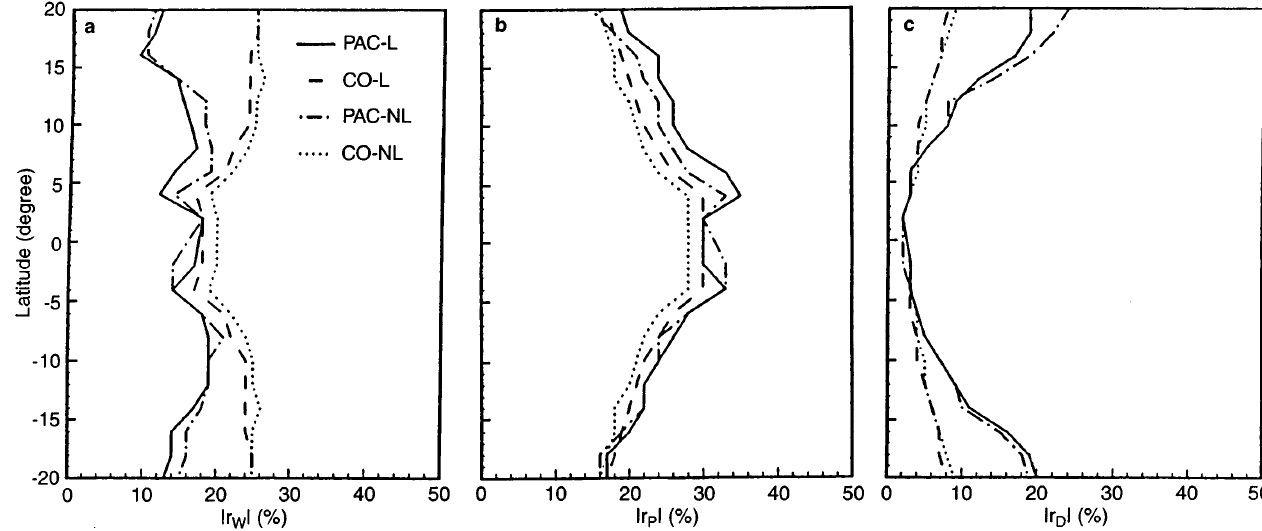
Fig. 2a–c. Energy flux coe(cid:129)cients (%) at di(cid:128)erent latitudes (degree). a r , b r and c r . Solid line : linear experiment with Pacific coastline W P D ( PAC-L ). Dashed line : linear experiment with meridional coastline